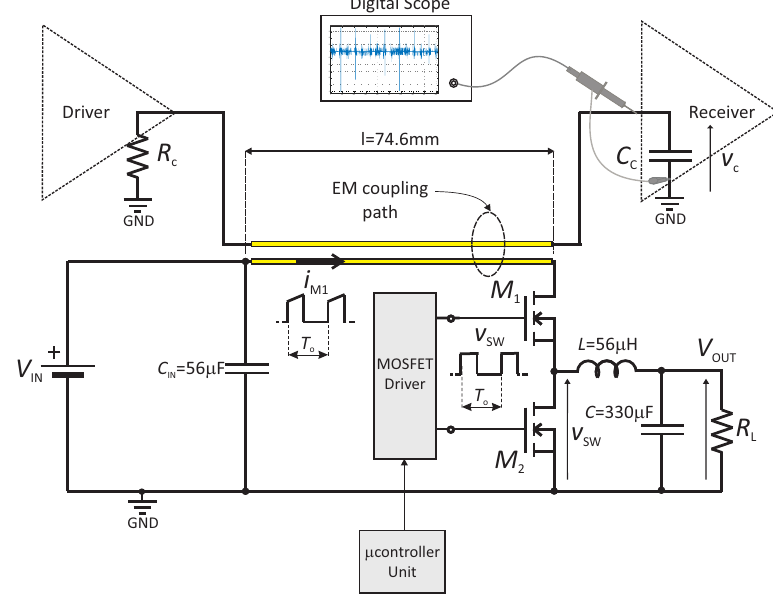
Figure 9. Schematic view of the test setup.